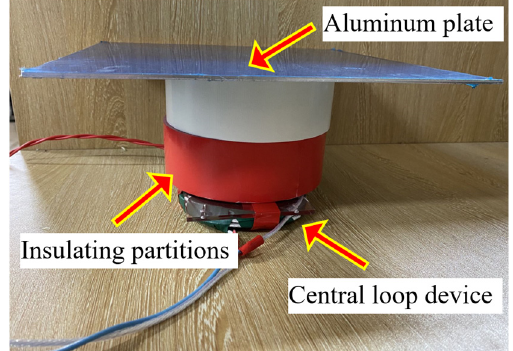
Figure 9. PEC test system for aluminum plate thickness detection. Aluminum plates of different thicknesses are placed above the inspection coil probe through non-magnetic insulating partitions, and the lift-off can be set to h = 50 mm or h = 100 mm by adjusting the number of insulating partitions. In the case of lift-off ℎ = 100 mm , the D-ATC curves of aluminum plates with thick- nesses 𝑑 = 1 mm , 3 mm, and 5 mm are shown as the blue dashed line, red dotted line, and yellow dash-dotted line in Figure 10, respectively. It can be seen that the steady-state values 𝜏 (cid:3002)(cid:3021)(cid:3004) (𝑇 (cid:3047)(cid:3045) ) of the three D-ATC curves obey the arithmetic progression, which veri- fies the linear relationship between the thickness 𝑑 and 𝜏 (cid:3002)(cid:3021)(cid:3004) (𝑇 (cid:3047)(cid:3045) ) shown in Figure 6b. On the other hand, the transient time 𝑇 (cid:3047)(cid:3045)(cid:2869) and 𝑇 (cid:3047)(cid:3045)(cid:2870) corresponding to the 1 mm and 3 mm thick aluminum plates are clearly distinguishable, which is deduced to be a poten- tial challenge, because the power law shown in Figure 6a reduces the resolution of 𝑇 (cid:3047)(cid:3045) for the thin plates. These characteristics are consistent with the simulation results in Section 4. Therefore, the 𝑇 (cid:3047)(cid:3045) and 𝜏 (cid:3002)(cid:3021)(cid:3004) (𝑇 (cid:3047)(cid:3045) ) signatures have sub-millimeter resolution for thick- ness variation.